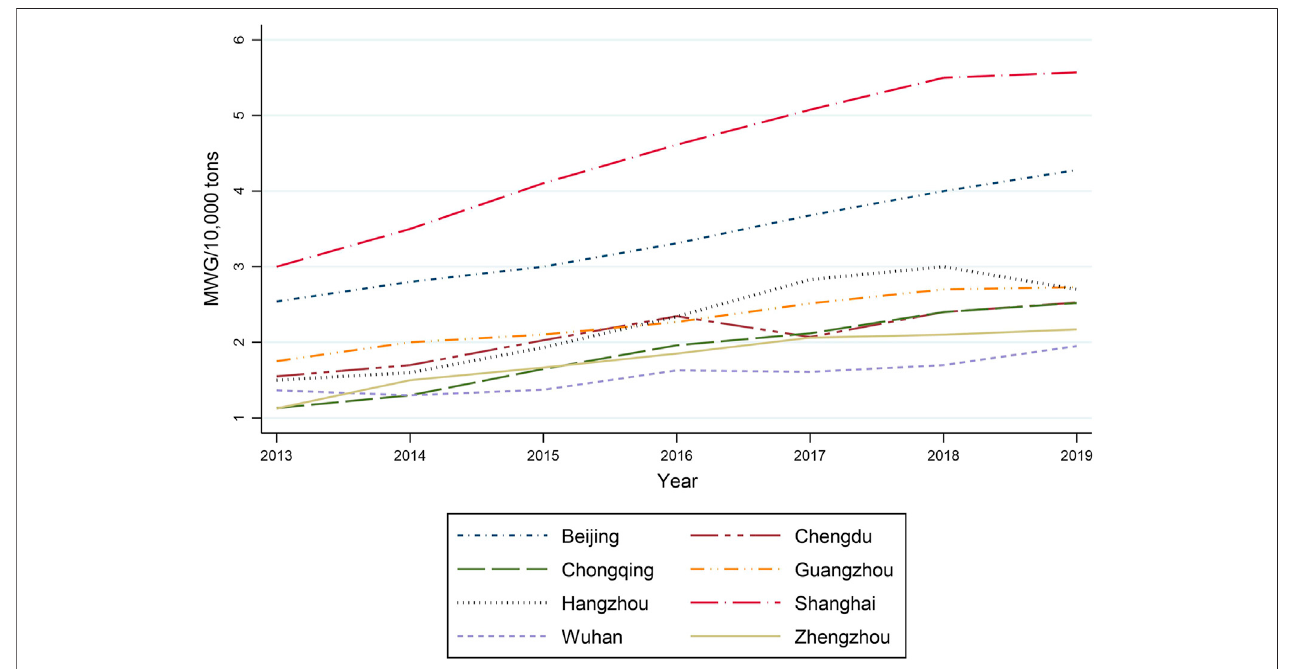
FIGURE 3 | The amount of MWG in eight cities from 2013 to 2019.